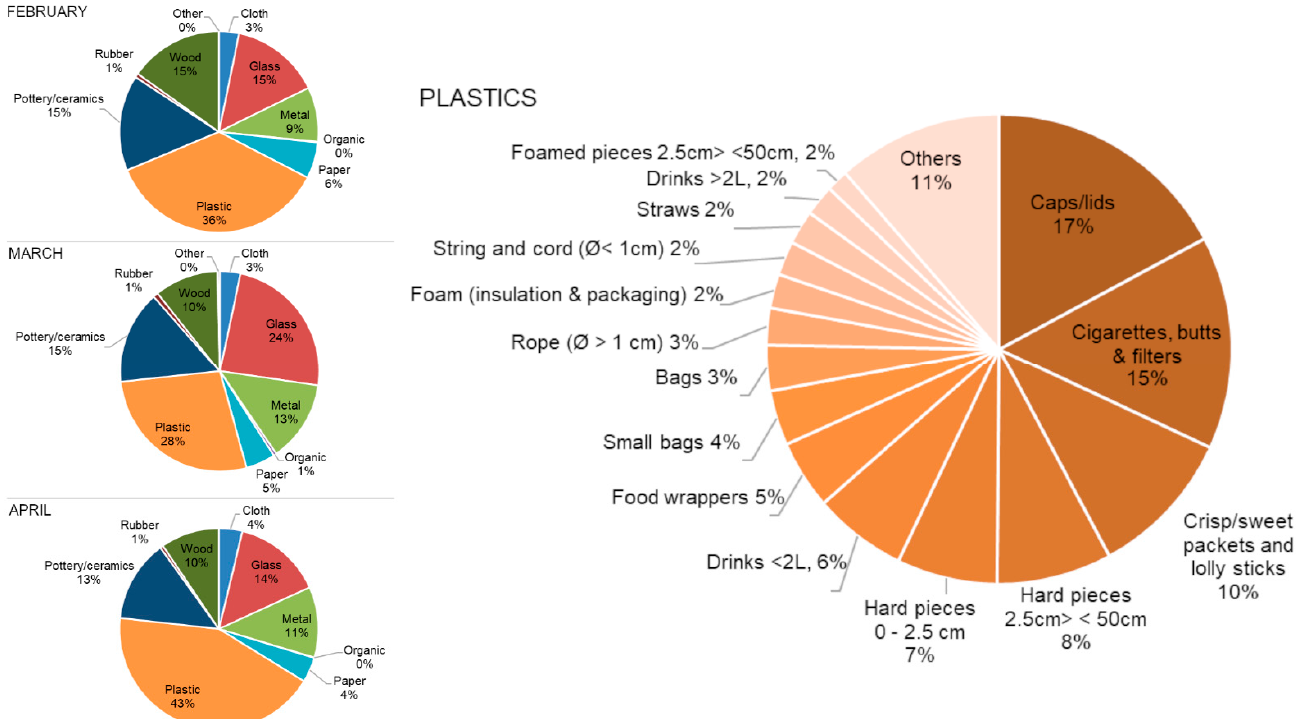
Table 4. Number of items of the most represented plastic litter categories per month. The highest values are highlighted in bold. Plastic Category